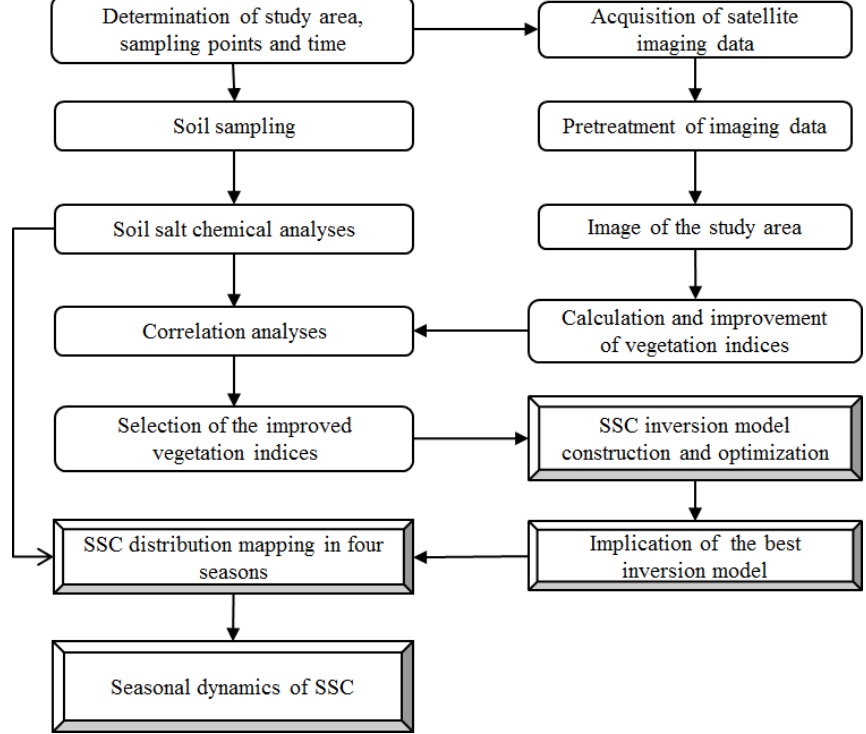
Figure 3. Methodological flow chart. Table 1. SSC descriptive statistics of samples and